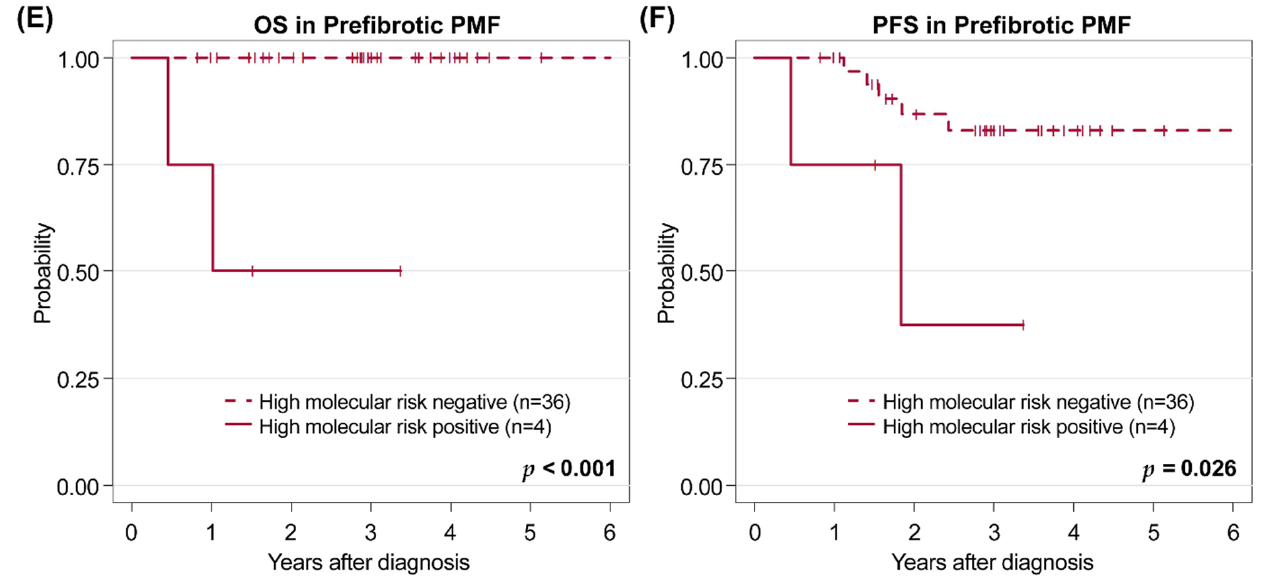
Figure 4. Estimation of overall survival (OS) in ( A ) primary myelofibrosis (PMF), ( C ) secondary myelofibrosis (SMF), and ( E ) prefibrotic myelofibrosis (pre-PMF), and progression-free survival (PFS) in ( B ) PMF, ( D ) SMF, and ( F ) pre-PMF after consideration of the high-risk molecular group.